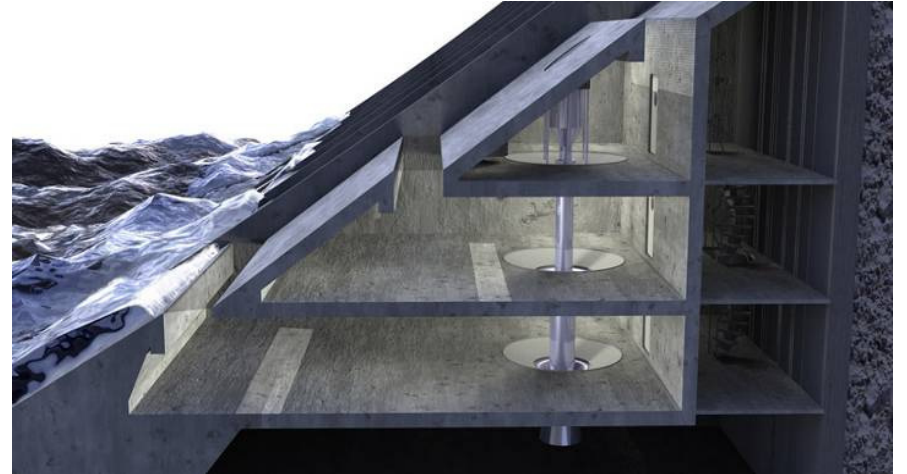
Figure 1. Artistic representation of a 3-level SSG (WAVEnergy SAS, 2003).